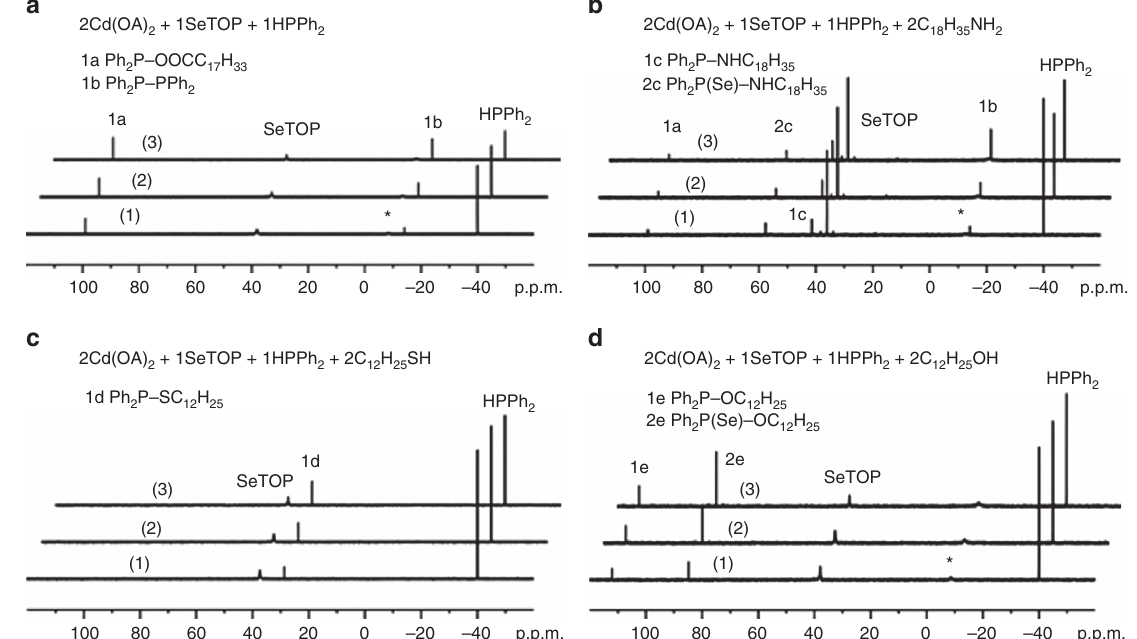
Figure 1 | 31 P NMR spectra of CdSe reaction mixtures with Se precursor. ( a ) 2Cd(OOCC 17 H 33 ) 2 þ SeTOP þ HPPh 2 . ( b ) 2Cd(OOCC 17 H 33 ) 2 þ SeTOP þ HPPh 2 þ 2C 18 H 35 NH 2 . ( c ) 2Cd(OOCC 17 H 33 ) 2 þ SeTOP þ HPPh 2 þ 2C 12 H 25 SH. ( d ) 2Cd(OOCC 17 H 33 ) 2 þ SeTOP þ HPPh 2 þ 2C 12 H 25 OH. The experiments were performed at RT for 15 (1), 30 (2) and 60min (3). The peak denoted with an asterisk (*) is TOP complexed to Cd (ref. 23). Interestingly,